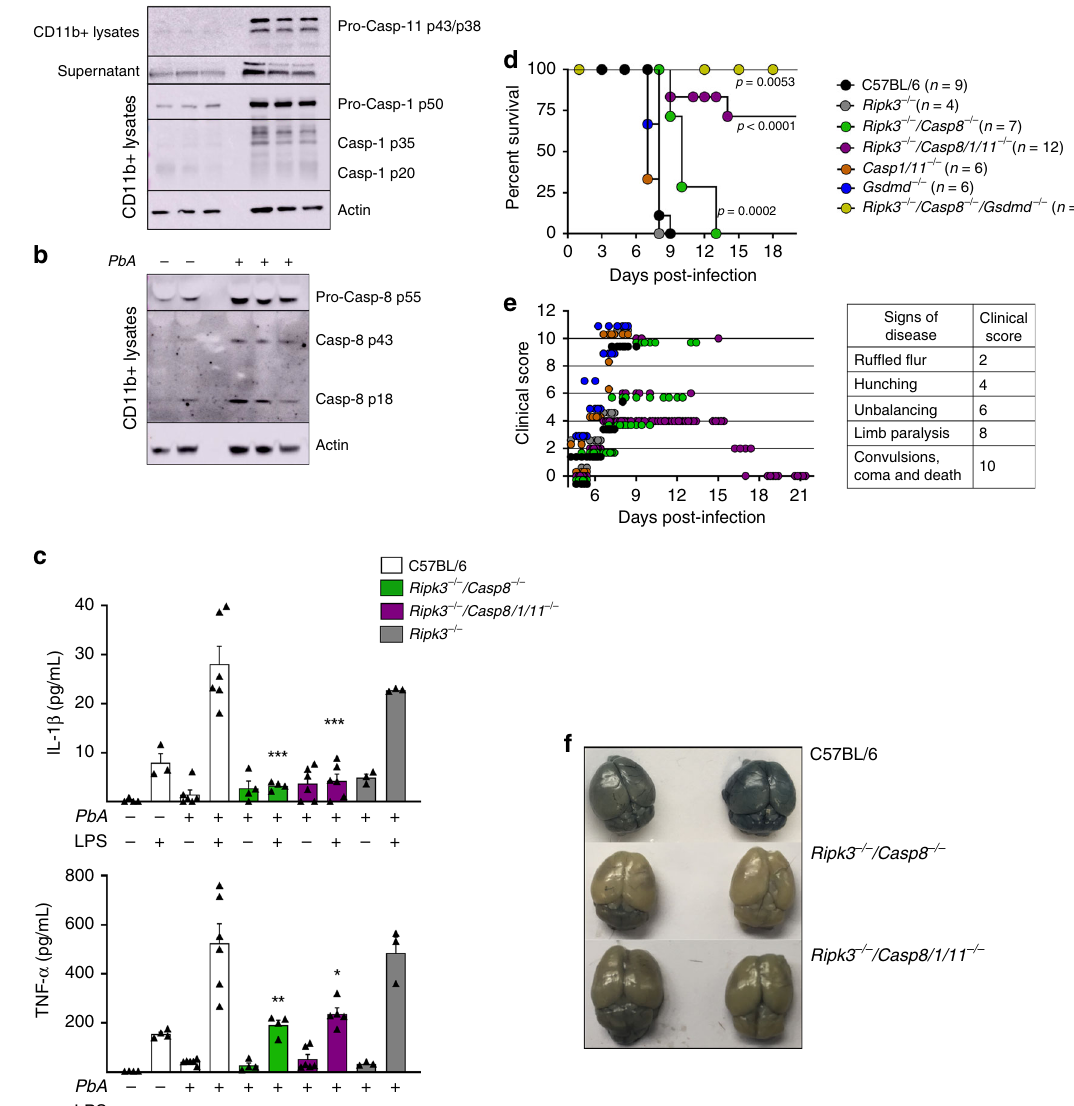
Fig. 6 Caspase-8 mediates experimental cerebral malaria (ECM) in PbA -infected mice. C57BL/6, Casp1/11 − / − , Gsdmd − / − , Ripk3 − / − (control), Ripk3 − / − /Casp8 − / − , Ripk3 − / − /Casp8/1/11 − / − , and Ripk3 − / − /Casp8 − / − /Gsdmd − / − mice were used in different experiments as indicated. CD11b + cells were puri fi ed from splenocytes harvested on days 0 and 5 post infection. Cells were lysed in RIPA buffer to prepare the lysates, and splenocytes were spin down 400 × g for 5 min to prepare supernatants. Western blots were revealed with ( a ) anti-caspase-1 and anti-caspase-11 or ( b ) anti-caspase-8 antibodies. c Splenocytes from uninfected controls and PbA -infected mice were stimulated in vitro with 1 μ g/ml of LPS, and 48 h later the levels of IL-1 β (top panel, *** P < 0.0001) and TNF α (bottom panel, * P = 0.0104 and ** P = 0.0056) measured in culture supernatants by ELISA. For IL-1 β : C57BL/6 (control n = 4, + LPS n = 3; infected n = 6), Ripk3 − / − /Casp8 − / − n = 4, Ripk3 − / − /Casp8/1/11 − / − n = 6, and Ripk3 − / − n = 3. For TNF α ː C57BL/6 (control n = 4, infected n = 6), Ripk3 − / − /Casp8 − / − n = 4, Ripk3 − / − /Casp8/1/11 − / − ( n = 6, + LPS n = 5), and Ripk3 − / − n = 3. d Survival of PbA -infected mice was followed by 21 days, and in ( e ), each of the classic CM symptoms (ruf fl ed fur, abnormal posture, unbalancing, limb paralysis, convulsion, coma, and death) was given a score (0, 2, 4, 8, or 10). f After 6 days of infection, mice were injected i.v. with 0.2 mL of 1% Evans blue (120 mg kg − 1 d − 1 ) at 6 days post infection of vehicle-treated mice. One hour later, mice were killed, and brain color was assessed. Naive mice were also injected with Evans blue and used as unstained control. In a , b , blots are representative of two different experiments. In c , mean ± s.e.m of two to three different experiments are shown; statistical analysis by one-way ANOVA. The survival curve was analyzed by log-rank Caspase-8 mediates P. berghei ANKA ( PbA )-induced ECM . (Fig. 6a), and -8 (Fig. 6b) proteins. Consistent with the results obtained with Pc -infected mice, we found that IL-1 β and TNF α Different studies have shown that double Casp1/11 − / − mice are produced by splenocytes stimulated with LPS were impaired still highly susceptible to ECM induced by PbA infection 50,51 . In both in PbA -infected Ripk3 − / − /Casp8 − / − and Ripk3 − / − /Casp8/1/ contrast, we found that caspase-8 contributes to the development of ECM. Consistent, with the gene expression analysis, our 11 − / − mice (Fig. 6c). Importantly, we observed a delay lethality of ex vivo results show that splenic CD11b + cells from PbA -infected Ripk3 − / − /Casp8 − / − infected with PbA , whereas Ripk3 − / − /Casp8/ mice express high levels of pro- and active caspases-1, -11 1/11 − / − and Ripk3 − / − /Casp8 − / − /Gsdmd − / − mice were highly